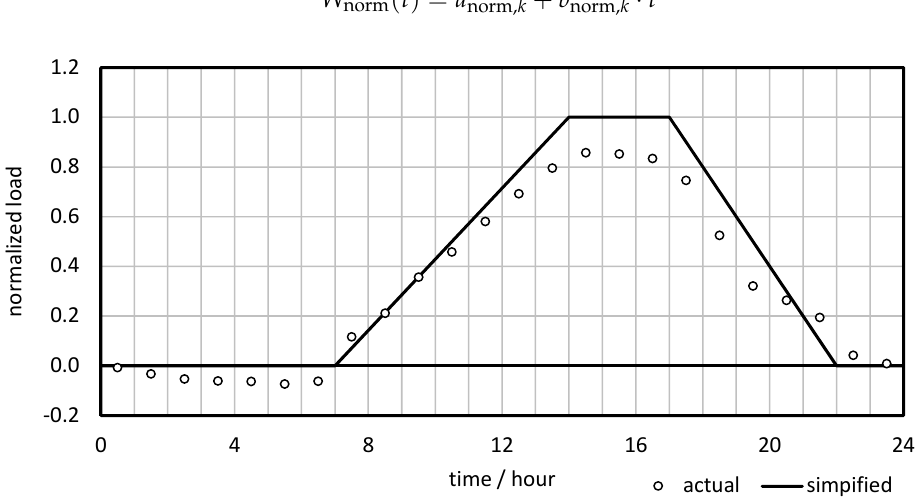
Figure 5. Average normalized daily load profile and the proposed simplified profile.